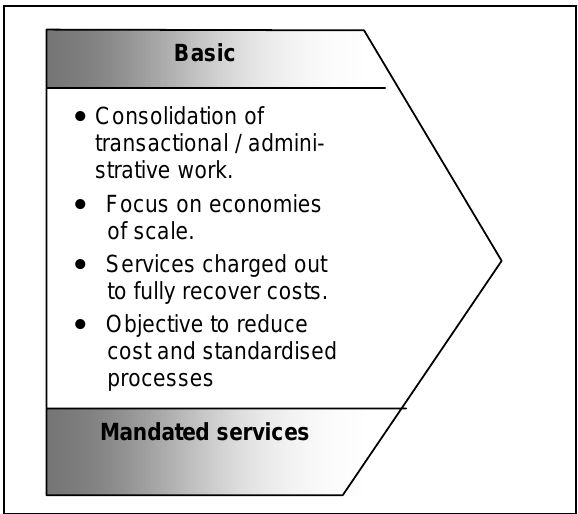
Figure 2: The basic shared services